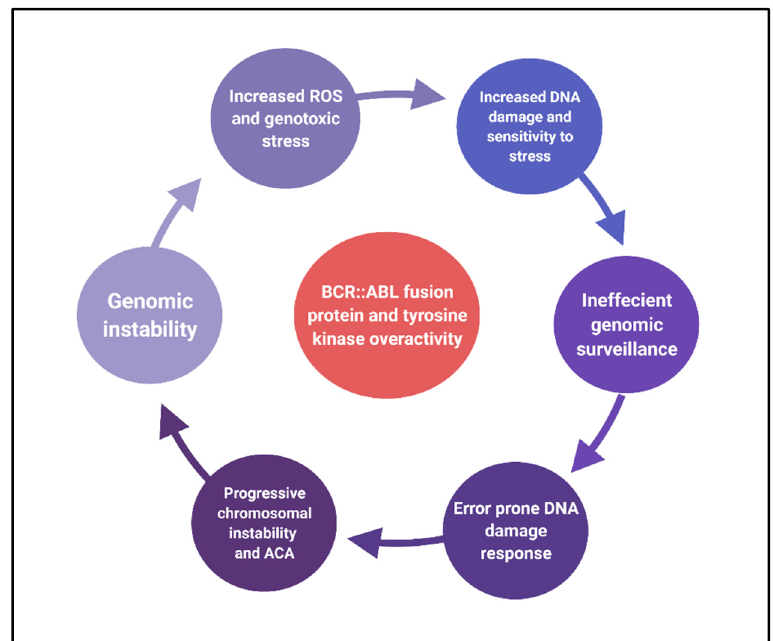
Figure 2. The vicious cycle of genomic and chromosomal instability in CML.